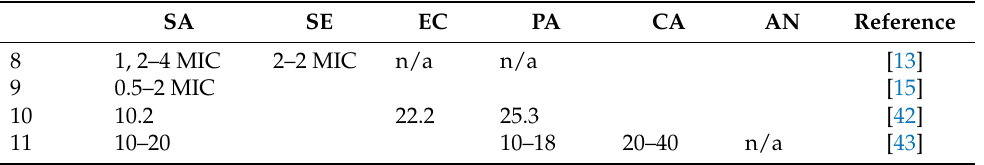
Table 5. Antimicrobial effects of cannabinoids and